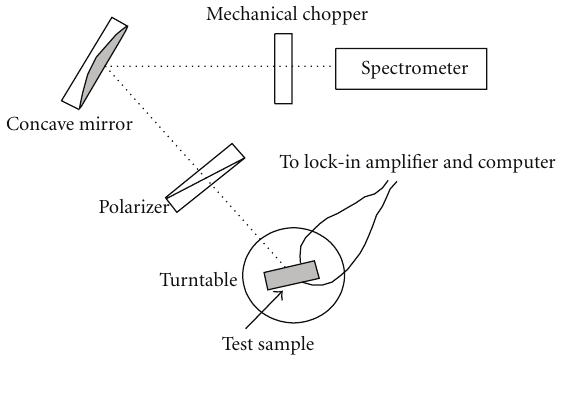
Figure 3: The experimental setup.